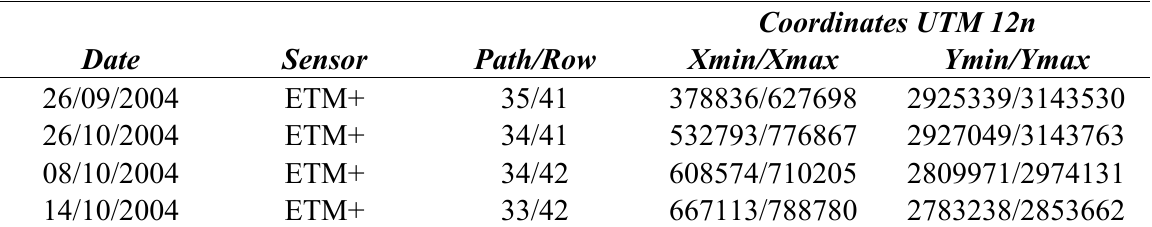
Table 1. Dates of the Landsat ETM+ images used in the present study.